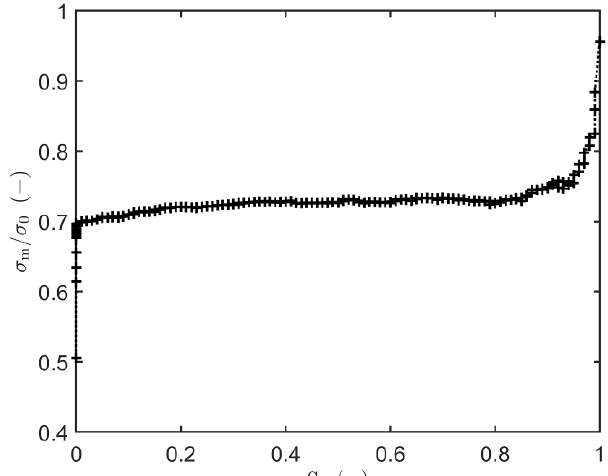
Figure 9. The exponent λ related with ( a ) and ( b ) the ratio of standard deviation over the mean radius 𝜎 0 / 𝑟̅ with pore connectivity Z = 6, and ( c ) pore connectivity at 𝜎 0 /𝑟 ̅ = 25/250 (µm). The values are averaged over 40 realizations.